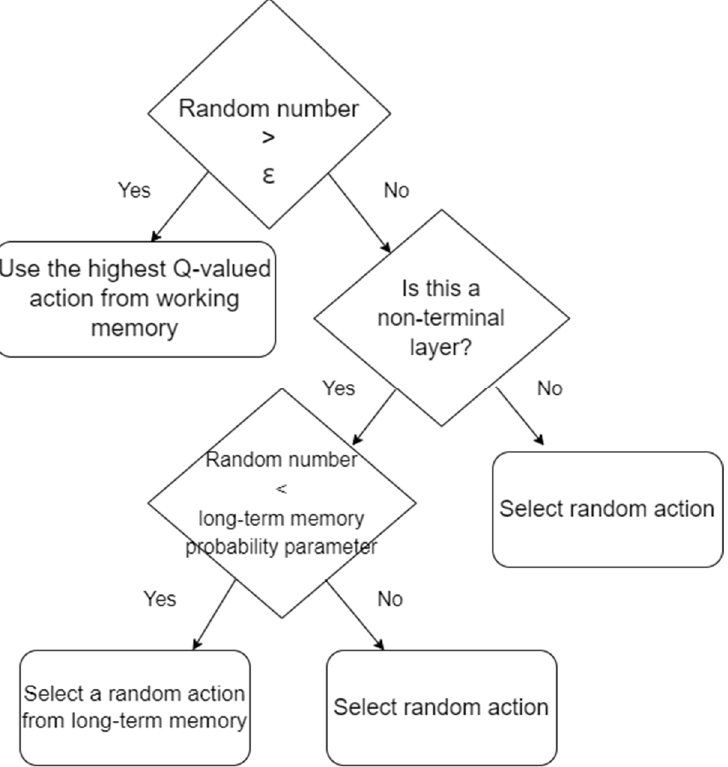
Figure 7. Action selection decision tree for the CLL with Q-learning. The (1+1) EA’s mutation rate is replaced with epsilon, although mutation and Q-learning’s exploration are similarly implemented here.